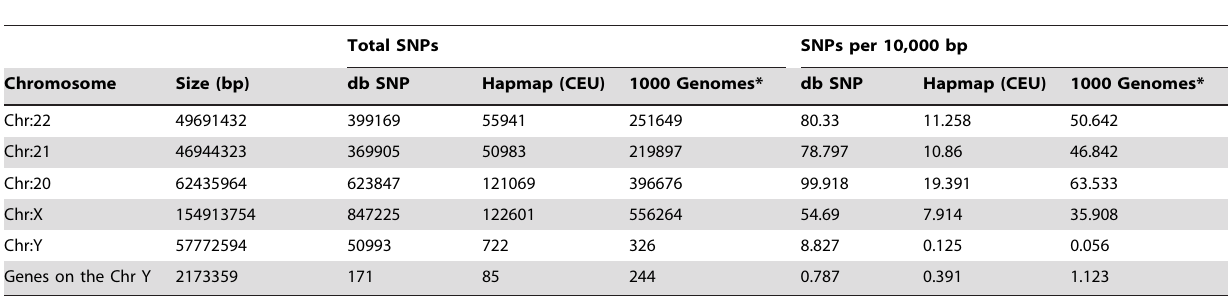
Table 3. Frequency of SNPs on the Y and other representative human